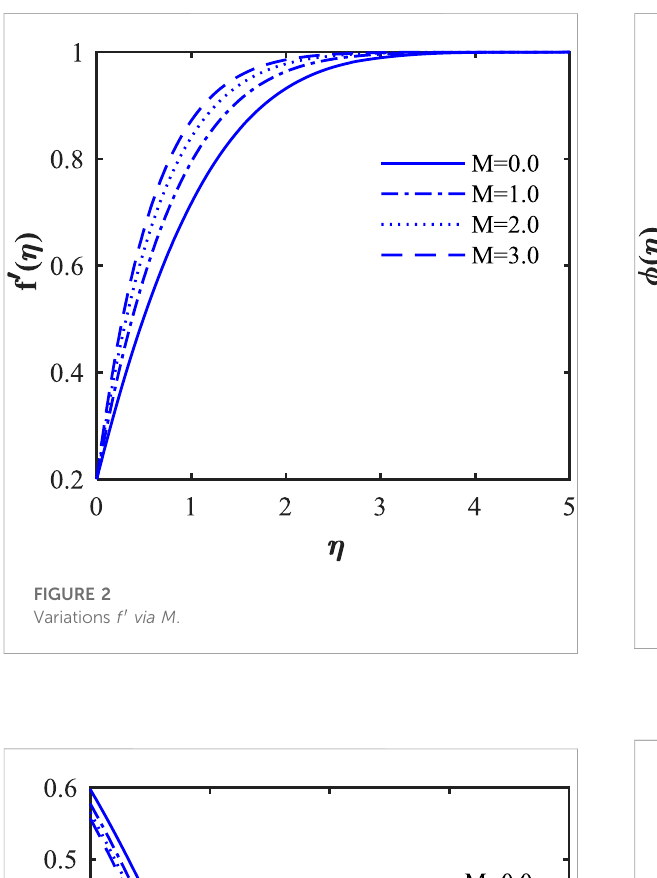
FIGURE 2 Variations f ′ via M